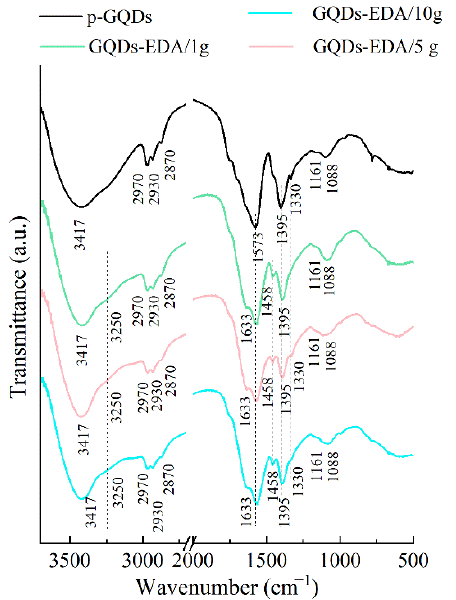
Figure 3. FTIR spectra of p-GQDs, GQDs-EDA/1 g, GQDs-EDA/5 g, GQDs-EDA/10 g.